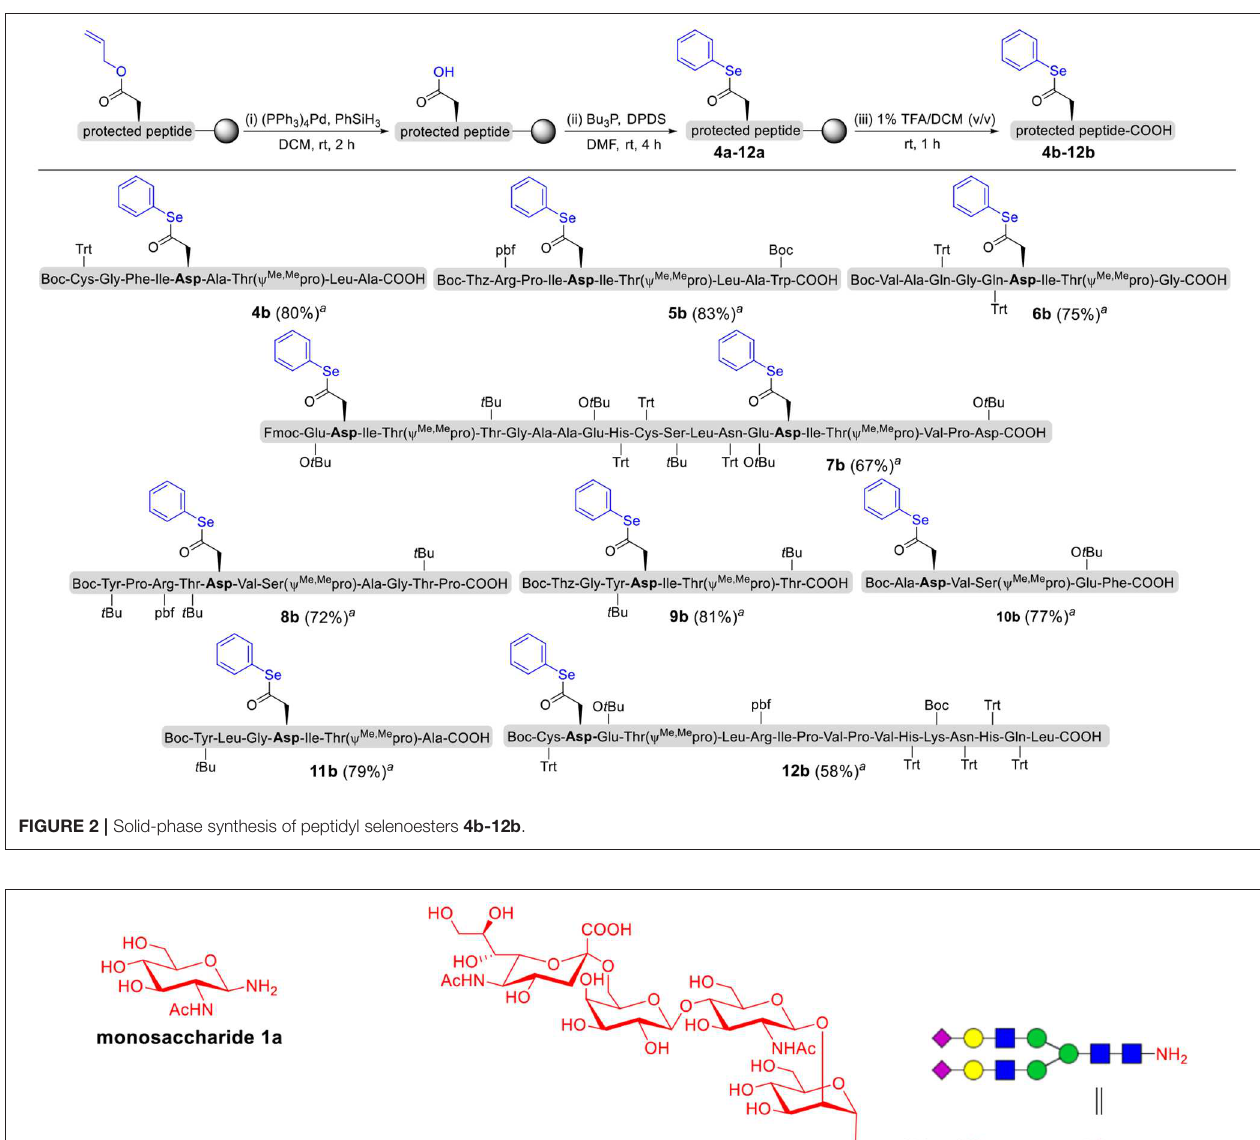
FIGURE 3 | Structures of glycosylamines 1a-1c